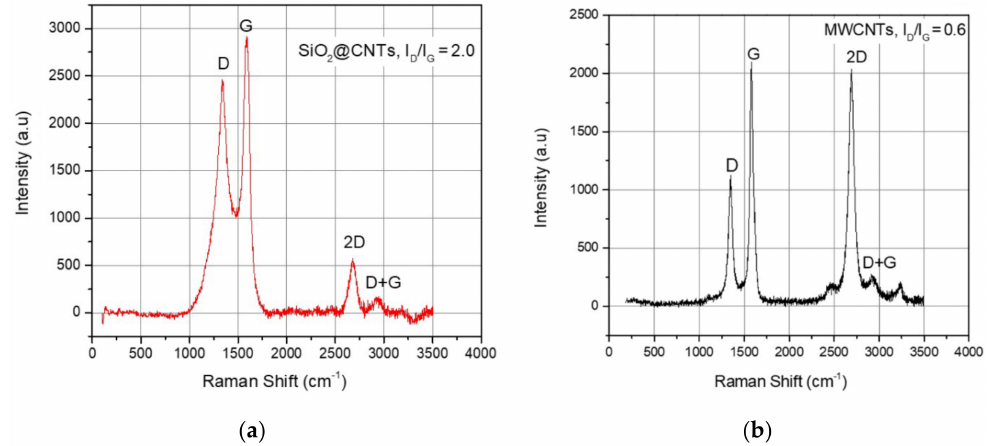
Figure 5. Raman shift of ( a ) SiO 2 @CNTs and ( b ) pristine commercial MWCNTs.